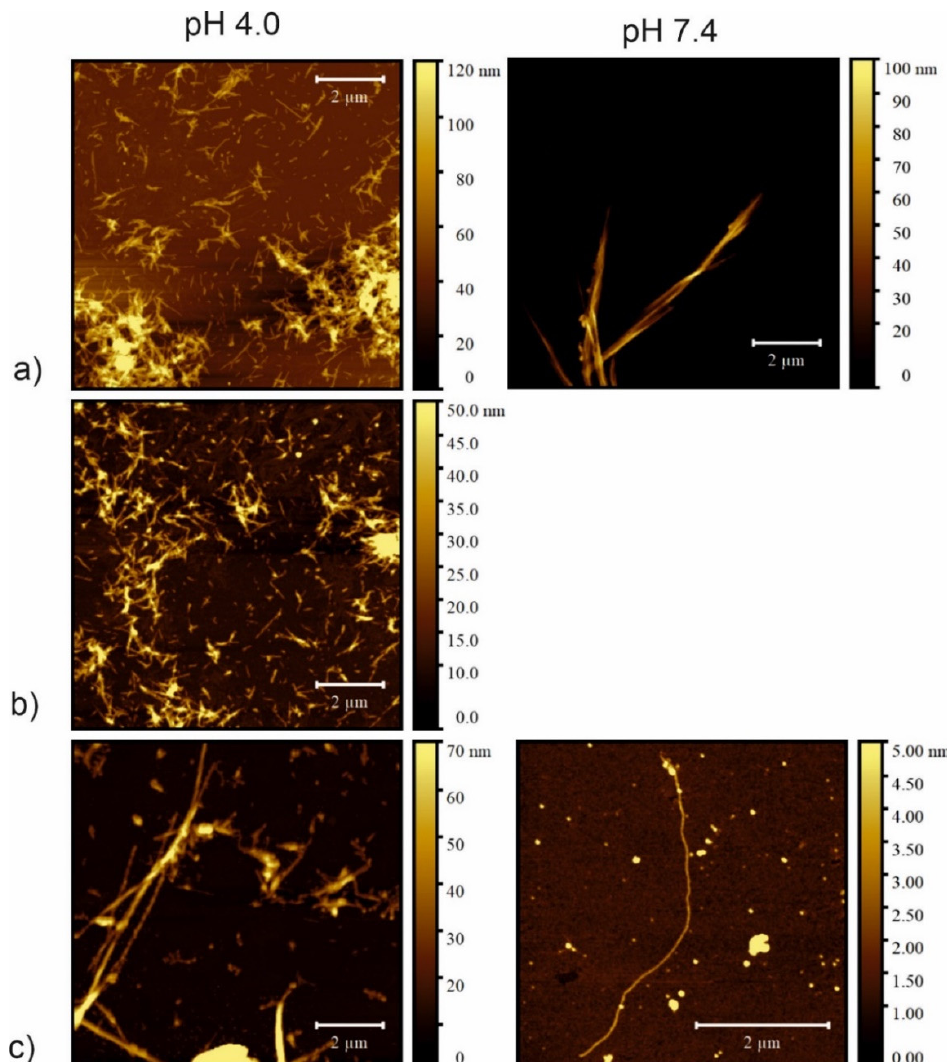
Figure 7. Atomic force microscopy (AFM) images of fibrils taken after 21 days of incubation in PBS buffer: left column pH 4.0; right column pH 7.4 of the peptides ( a ) CysZ4; ( b ) CysZ9 and ( c ) CysZ13.